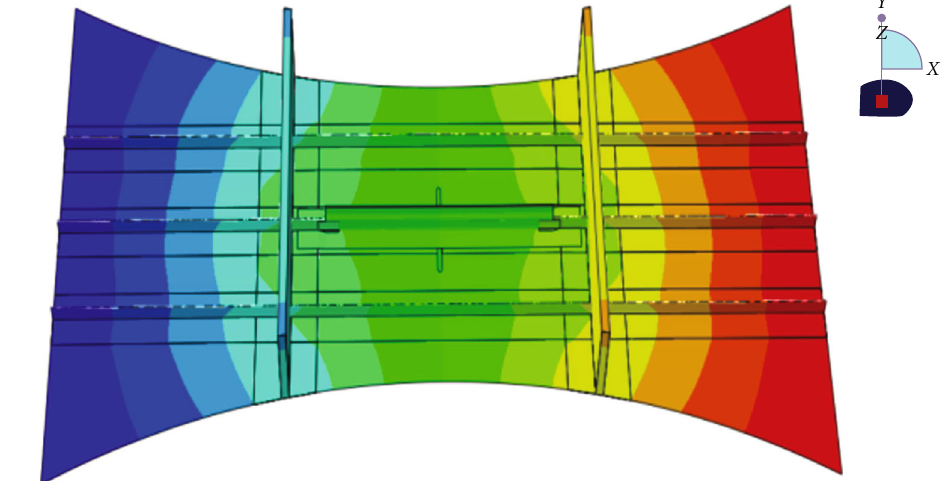
Figure 20: UMAT analysis repaired panel in-plane displacement